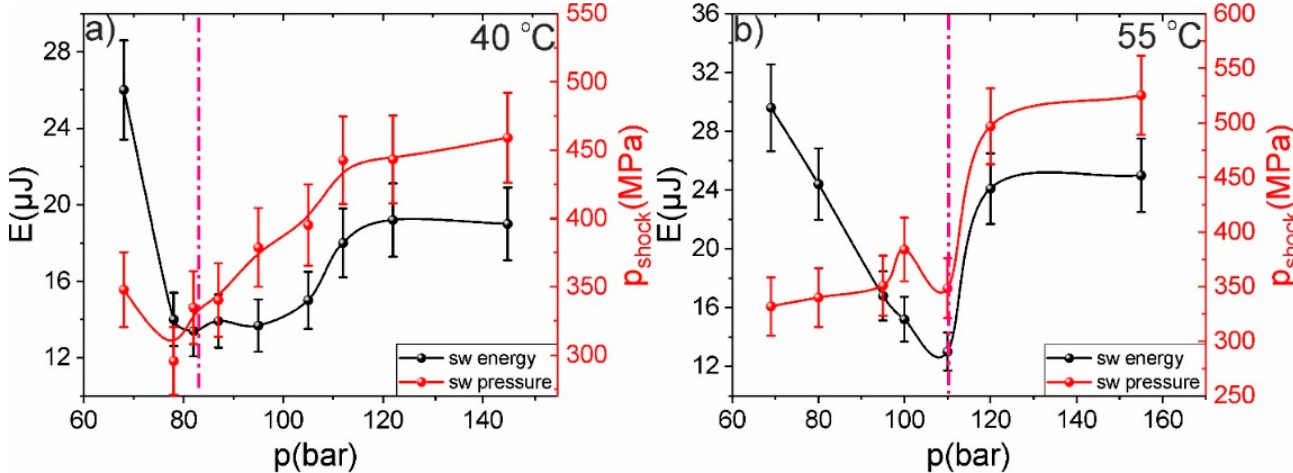
Figure 4. ( a , b ) Dependence of the shock wave energy (black line) and shock wave pressure (red bar) on the pressure inside the supercritical cell for different temperatures. Dash–dot line indicates the Widom line (the minimum sound speed).